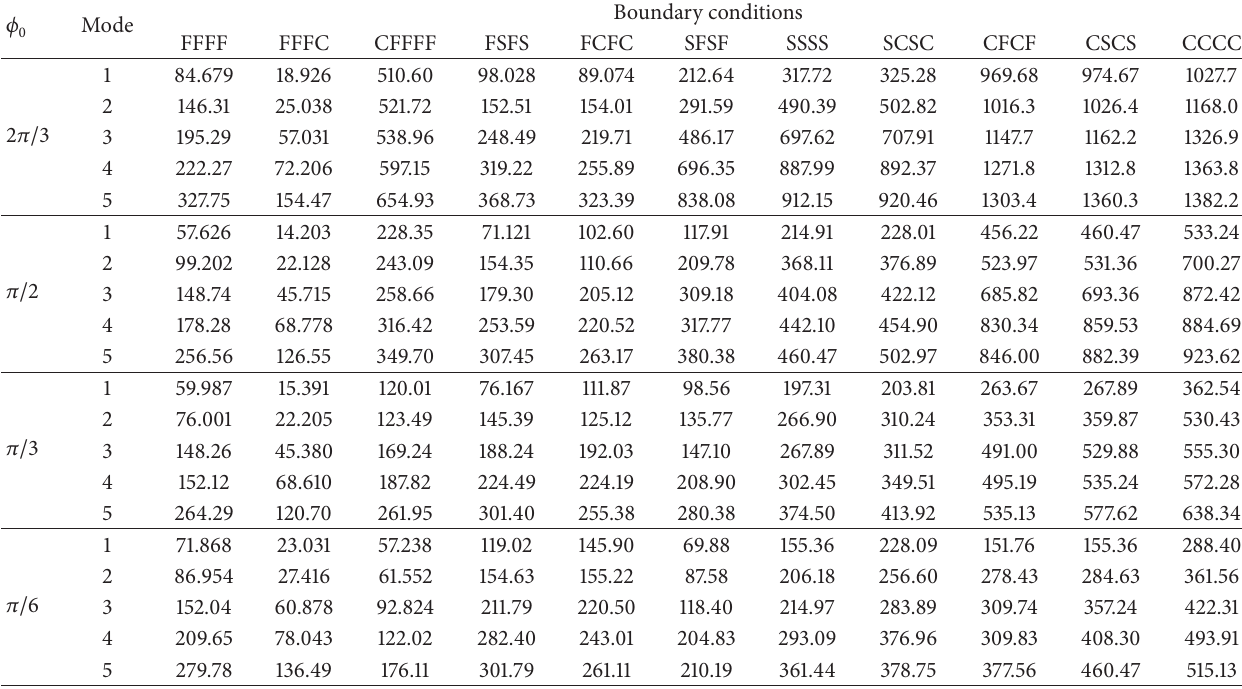
Table 17: The first five frequencies (Hz) of an open orthotropic spherical shell with various boundary conditions and meridian